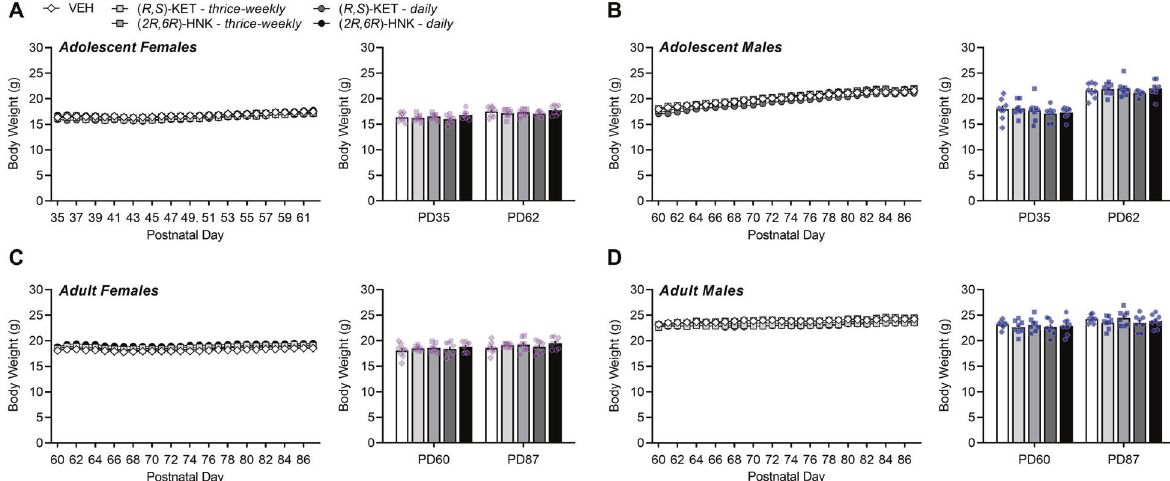
Fig. 2 Body weight is not in fl uenced by ( R,S )-ketamine or ( 2R,6R )-hydroxynorketamine regardless of sex or age of exposure. Body weight of adolescent female ( A ), adolescent male ( B ), adult female ( C ), and adult male ( D ) BALB/c mice over 4 weeks of treatment: 0.9% saline (vehicle, VEH; white/diamonds), thrice-weekly ( R,S )-KET (light-gray/square), thrice-weekly ( 2R,6R )-HNK (dark-gray/square), daily ( R,S )-KET (dark-gray/ circle), daily ( 2R,6R )-HNK (black/circle). Data are presented as mean ± standard error of the